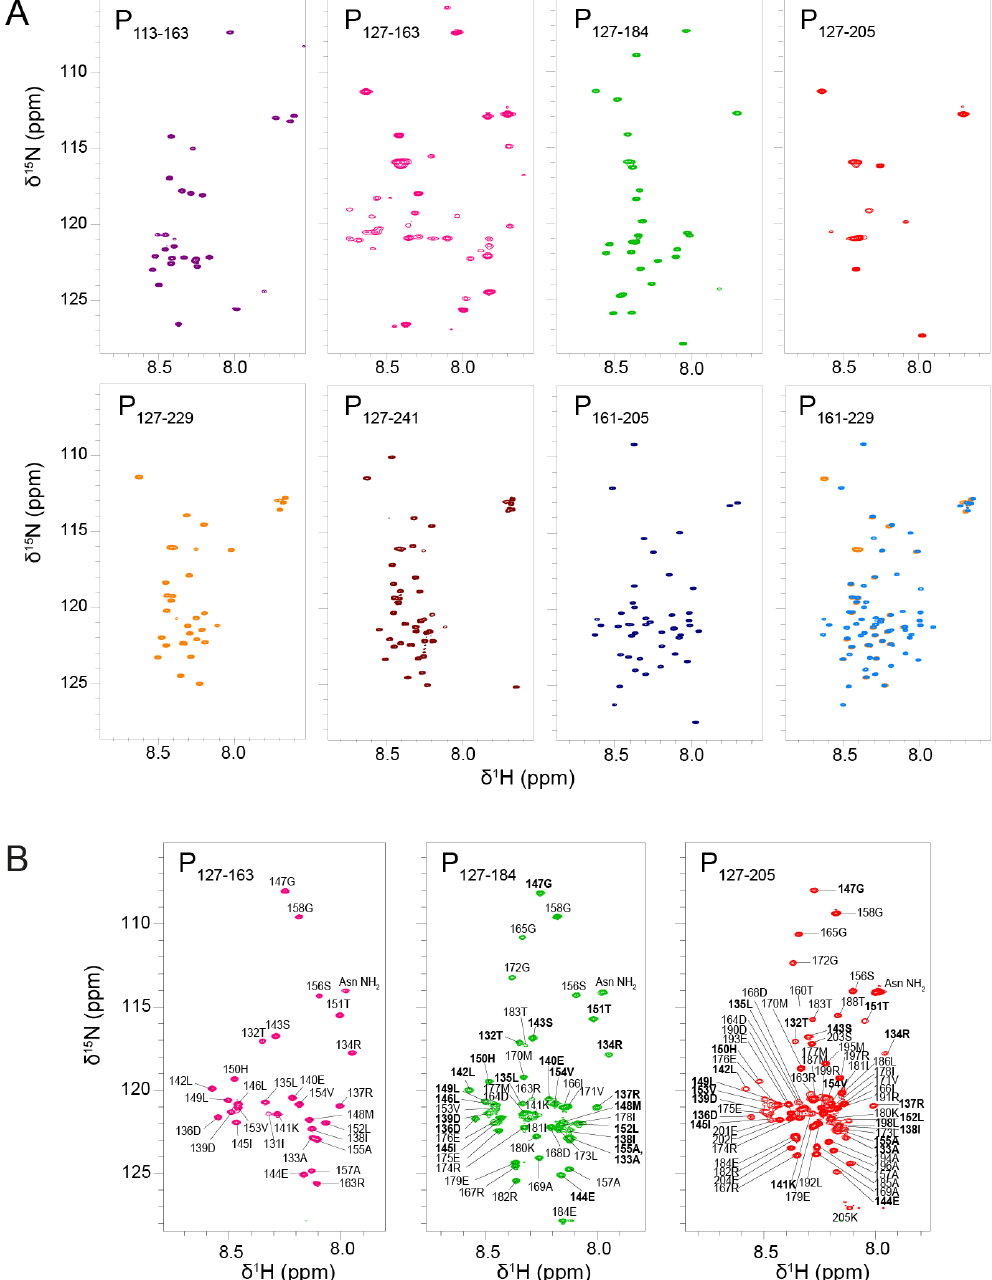
Figure 2. NMR fingerprints of RSV phosphoprotein fragments. ( A ) 2D 1 H- 15 N HSQC spectra of eight 15 N-labeled RSV P fragments were recorded at low temperature (288 K) in 20 mM phosphate pH 6.5, 100 mM NaCl buffer and at 150–300 µM concentrations. These fragments either contain the oligomerization domain (P OD ) with an N-terminal extension (P 113–163 ), only P OD (P 127–163 ), P OD with C-terminal extensions of different lengths (P 127–184 , P 127–205 , P 127–229 and P 127–241 ) or only C-terminal extensions (P 161–205 and P 161–229 ). NMR data were measured at 600 MHz 1 H Larmor frequency for all fragments, except P 113-163 that was measured at 700 MHz. Each fragment was assigned a color: P 113–163 (purple), P 127–163 (pink), P 127–184 (green), P 127–205 (red), P 127–229 (orange), P 127–241 (maroon), P 161–205 (marine), and P 161–229 (medium blue). The spectrum of P 127–229 (orange) was superimposed onto that of P 161–229 (blue). Spectra were plotted with comparable contour levels. ( B ) 2D 1 H- 15 N HSQC spectra of three 15 N-labeled RSV P fragments were measured at high temperature (313 K) on a 600 MHz NMR spectrometer. Amide signals are annotated with residue number and amino acid type. P OD residues are highlighted in bold letters.